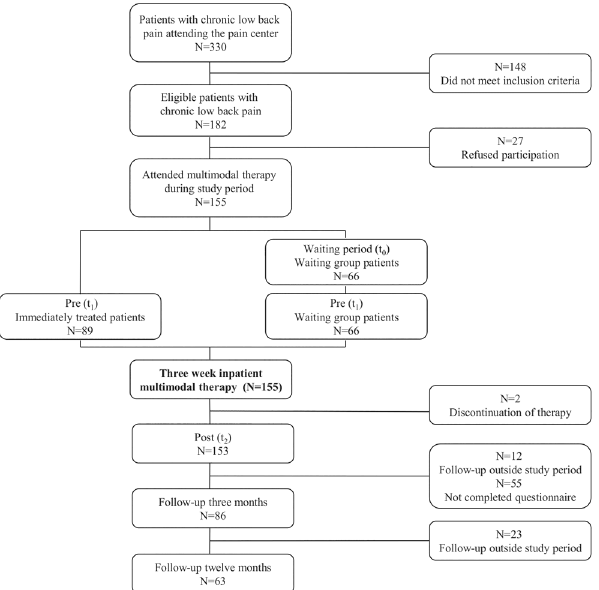
Fig 1. Flowchart with number of participants and dropouts for baseline, pre-treatment, post-treatment and follow-up at three and twelve months.